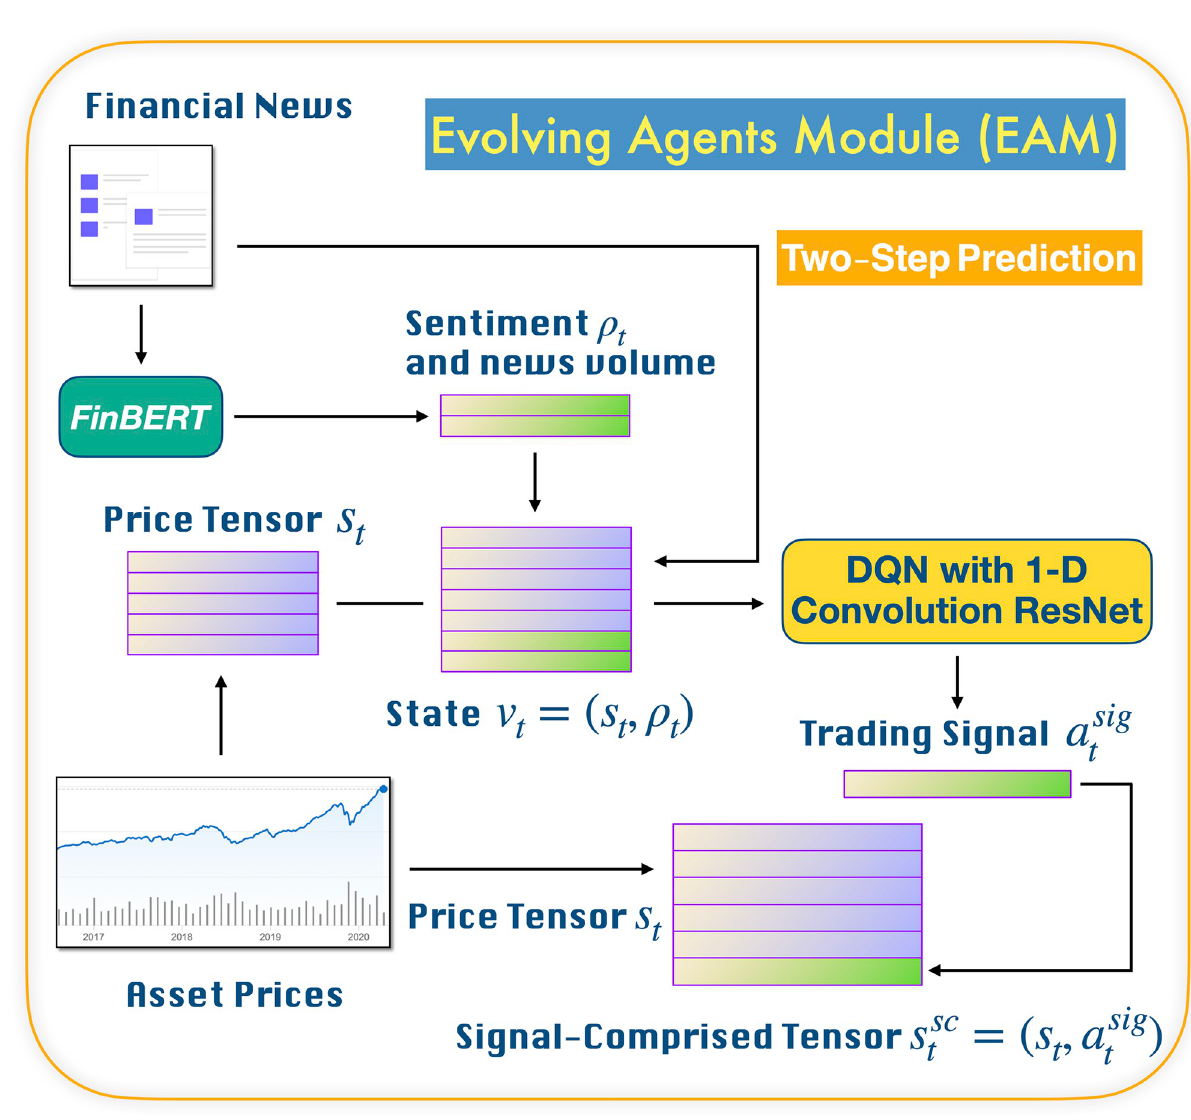
Fig 3. Abstract of EAM’s architecture. An EAM is a module for a designated asset. Each EAM takes two types of heterogeneous data: 1. designated asset’s historical prices and 2. asset-related financial news. At the center of an EAM is an extended DQN agent using a 1-D convolution ResNet for sequential decision making. Instead of training every EAM from scratch, we train EAMs by transfer learning using a foundational EAM. At every time step t , the DQN agent in EAM observes state v of either buying, selling, or skipping, and eventually generates a 2-D signal-comprised tensor s sc